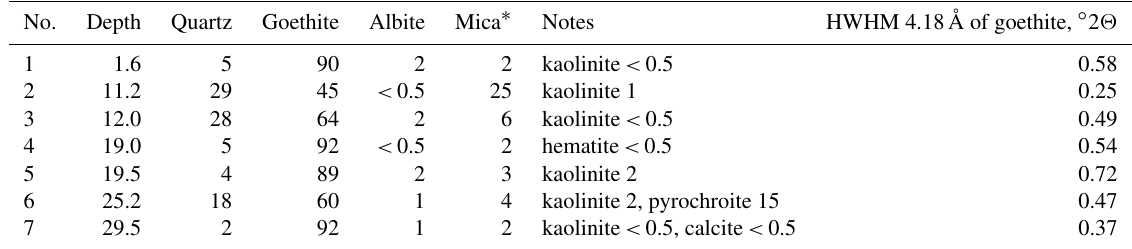
Table 1. Mineral composition of the brown iron ore from borehole no. 5889 according to XRD analysis (wt%). No. Depth Quartz Goethite Albite Mica ∗ Notes HWHM 4.18Å of goethite, ◦ 2 (cid:50) 1 1.6 5 90 2 2 kaolinite < 0.5 0.58 11.2 29 45 < 0.5 25 kaolinite 1 0.25 12.0 28 64 2 6 kaolinite < 0.5 0.49 19.0 5 92 < 0.5 2 hematite < 0.5 0.54 5 19.5 4 89 2 3 kaolinite 2 0.72 25.2 18 kaolinite 2, pyrochroite 15 0.47 29.5 92 kaolinite < 0.5, calcite <